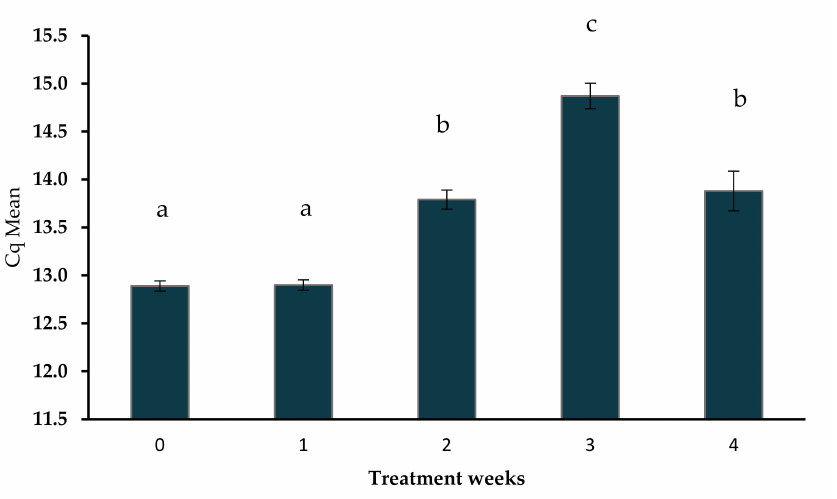
Figure 3. Effect of the treatment weeks over the Cq mean; different letters mean significant differences ( p < 0.05) in the t -test.